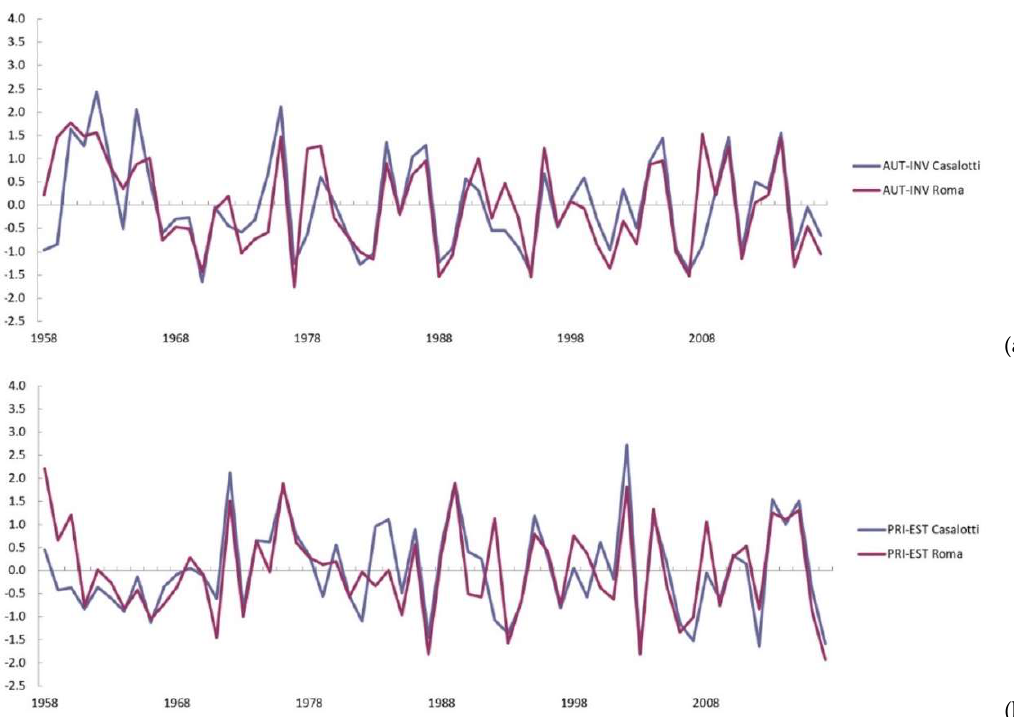
Figure 6. Standardized Precipitation Index (6 months’ time window) in Casalotti (blue) and Collegio Romano (red) by year, 1958–2017 from top to low panels: autumn-winter (a) and spring-summer (b).